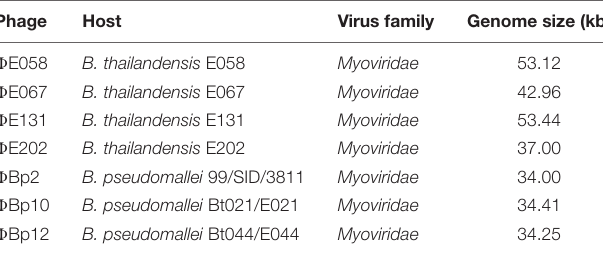
TABLE 2 | Origin, morphology, and estimated genome sizes of the isolated phages.